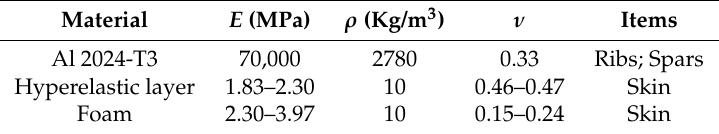
Table 2. FEM materials.